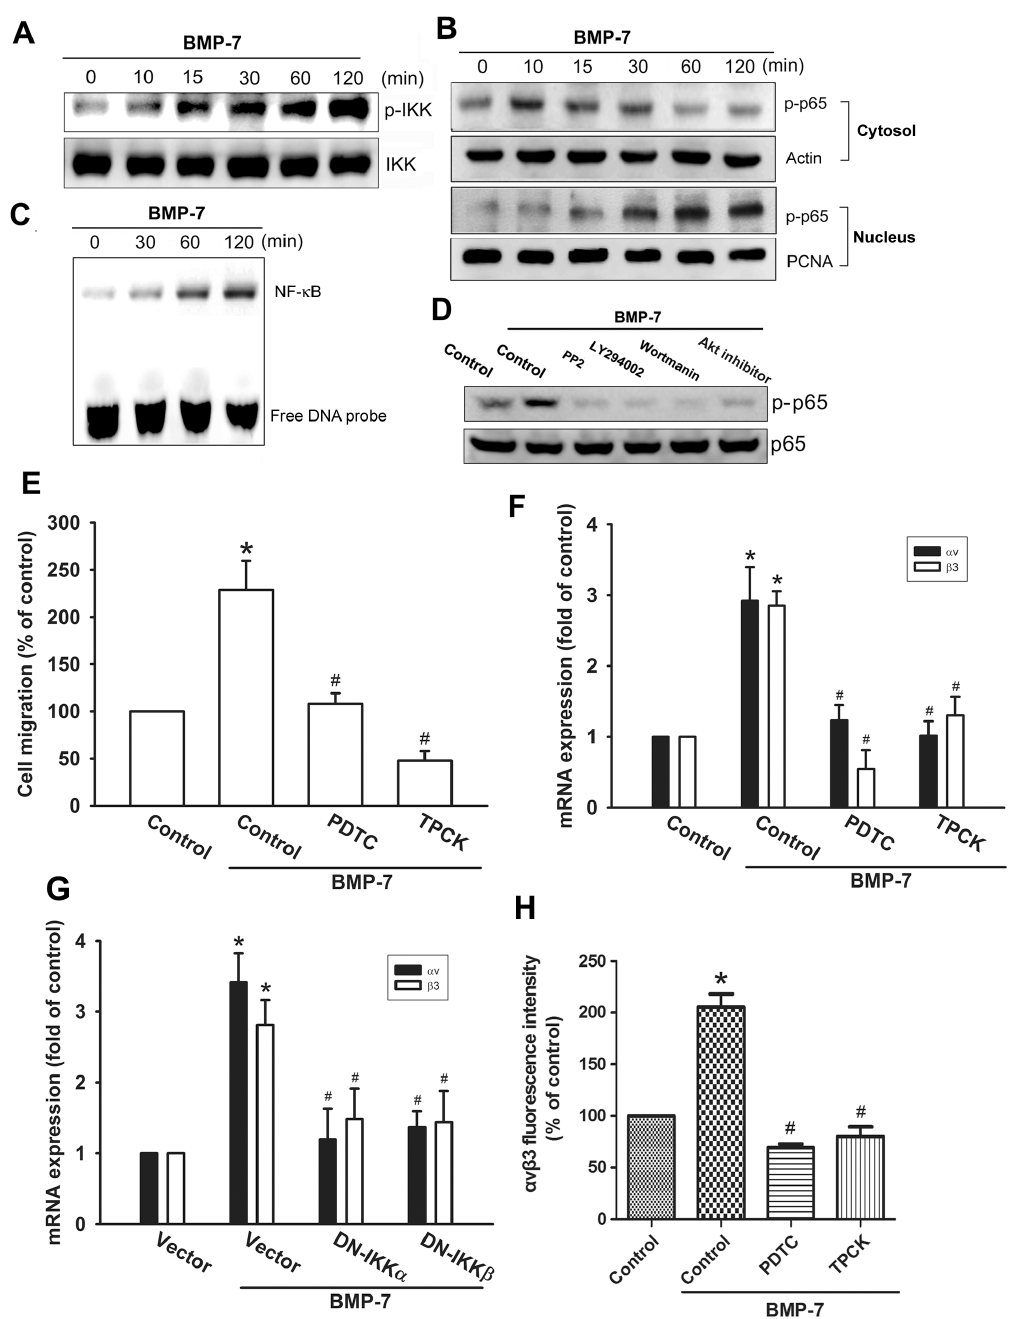
Figure 5. The IKK/NF- k B activation pathway is required for BMP-7-induced cell migration and up-regulation of integrin a v b 3. (A&B) JJ012 cells were incubated with BMP-7 for indicated time intervals. The phosphorylation status and total levels of IKK were measured by Western blot (A). The phosphorylated p65 in cytosol and nucleus were measured by Western blot. The actin and proliferating cell nuclear antigen (PCNA) was used as a loading control for cytosol and nuclear extract, respectively (B). (C) Cells were incubated with BMP-7 for indicated time intervals, and electrophoretic mobility shift assay was performed as described in the Materials and Methods Section. (D) Cells pretreated with PP2, Ly294002, wortmannin, or Akt inhibitor for 30 min followed by treatment with BMP-7 for 2 h. The levels of p-p65 and p65 were measured by Western blot. Data are representative of at least three independent experiments. (E) Cells were pretreated with PDTC (10 m M) or TPCK (10 m M) followed by stimulation with BMP-7 for 24 h, and in vitro migration was measured by Transwell (n=4). (F–H) Cells were pretreated with PDTC (10 m M) or TPCK (10 m M) for 30 min or co-transfected with IKK a and IKK b mutant for 24 h followed by incubation with BMP-7 for 24 h. The expression of integrin a v b 3 was measured by q-PCR (F, G) (n=4) and flow cytometry (H) (n=5). Results are expressed as the mean 6 SEM. * p , 0.05, compared to basal expression levels. # p , 0.05, compared to expression levels in the BMP-7-treated group.